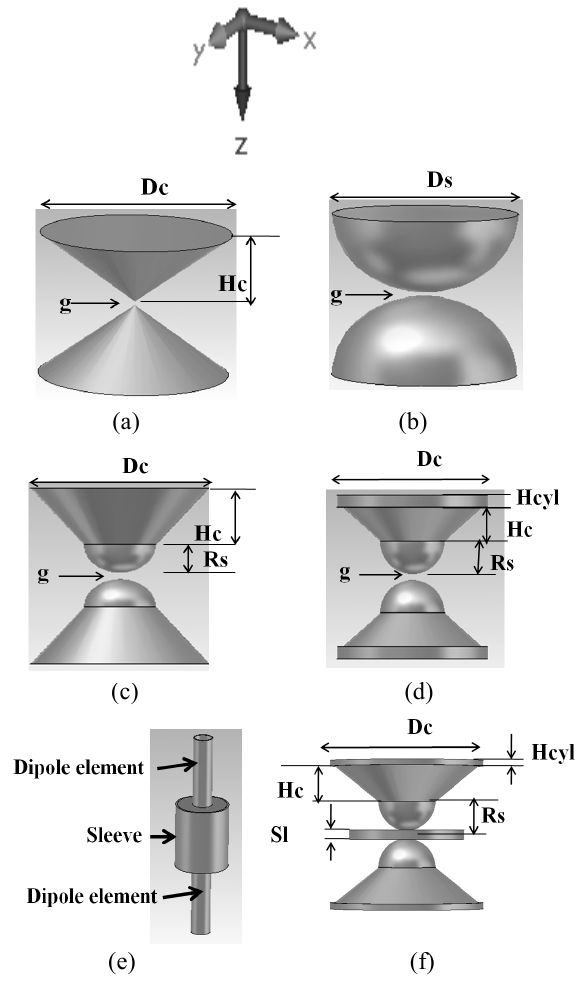
Figure 1: Various types of antenna configurations studied (a) Biconical Antenna (BCA), (b) Hemispherical Dipole Antenna (HDA) (c) Hemispherical Dipole with Conical Extensions (HDC) (d) Hemispherical Dipole with Conical Extensions and Cylindrical loading (HDCCL) (e) Geometrical configuration of sleeve dipole antenna (f) Canonical Sleeve Antenna (CSA)